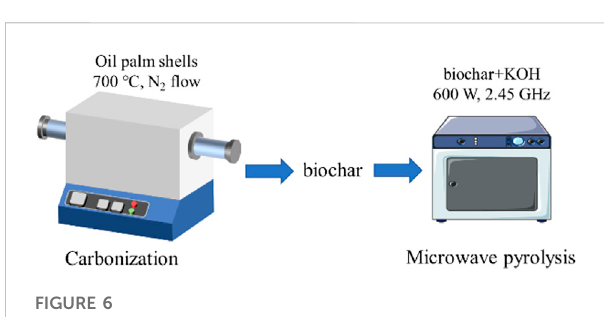
Two-step procedure of carbonization, followed by microwave